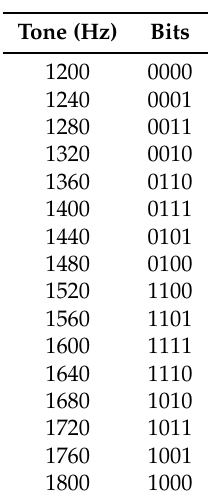
Table 2. 16 different tones in proposed MFSK16.